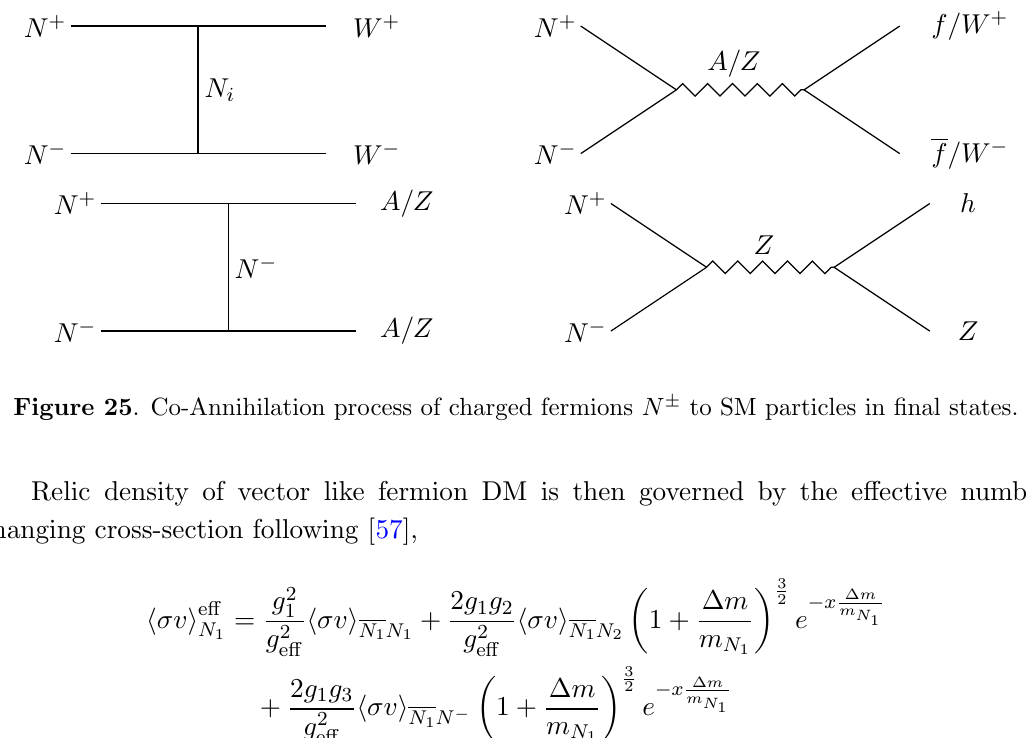
Figure 24 . Co-annihilation process of N i ( i = 1 ; 2) with the charge component N (cid:0) to SM particles.